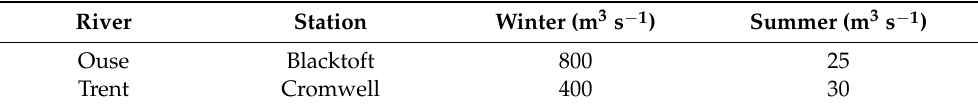
Table 3. Typical freshwater flows under high and low conditions from Rivers Ouse and Trent